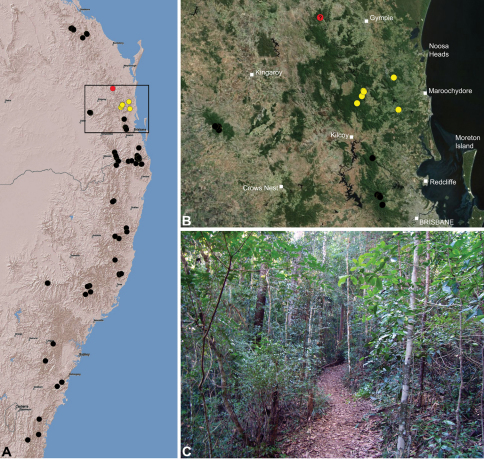
Austrarchaea judyae sp. n., distribution and habitat: A, topographic map showing the known distribution of Archaeidae in south-eastern Queensland and eastern New South Wales, with collection localities for A. judyae highlighted in yellow (red highlighted localities denote juvenile specimens of tentative identification); B, satellite image showing detail of inset (A); C, subtropical rainforest at the type locality – near Booloumba Creek, Conondale National Park, Queensland (May 2010). Image (C) by M. Rix.